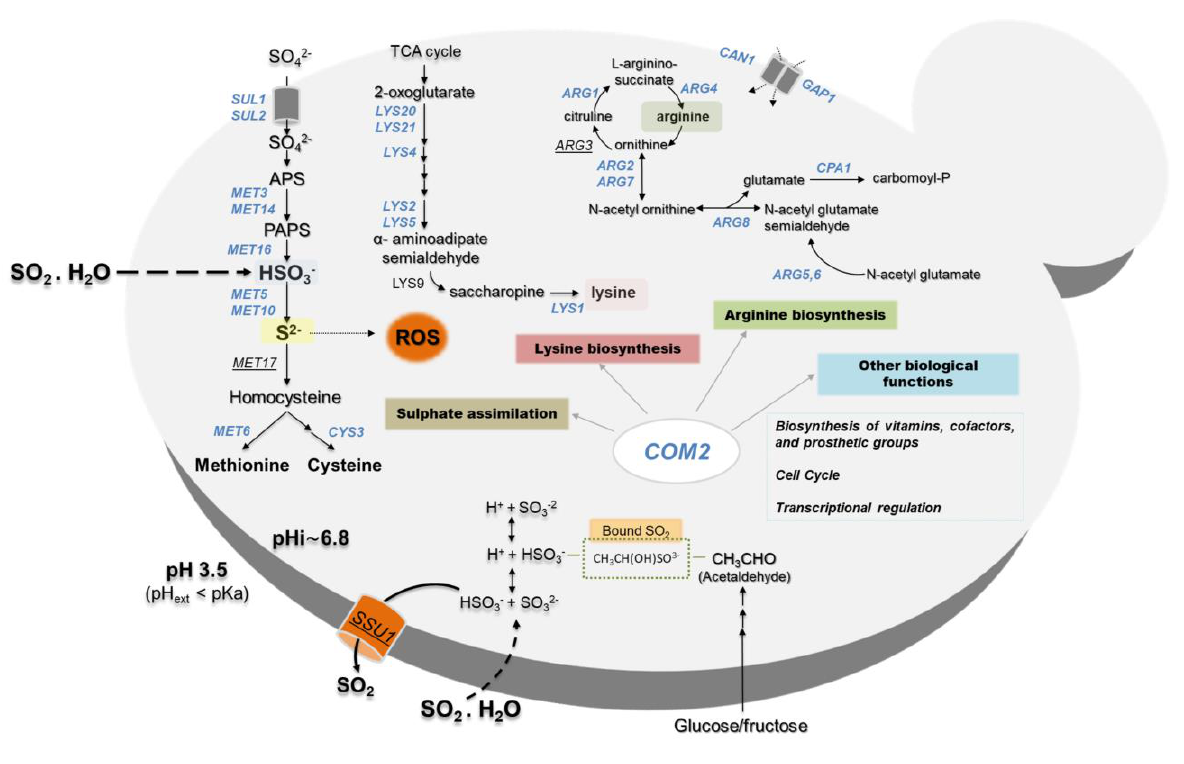
FIGURE 6. Schematic model for the adaptive response of S. cerevisiae to SO 2 -induced stress according with the results obtained in the herein described transcriptomic and chemogenomic analyses and also integrating previously described adaptive responses. Genes regulat- ed by Com2 are highlighted in